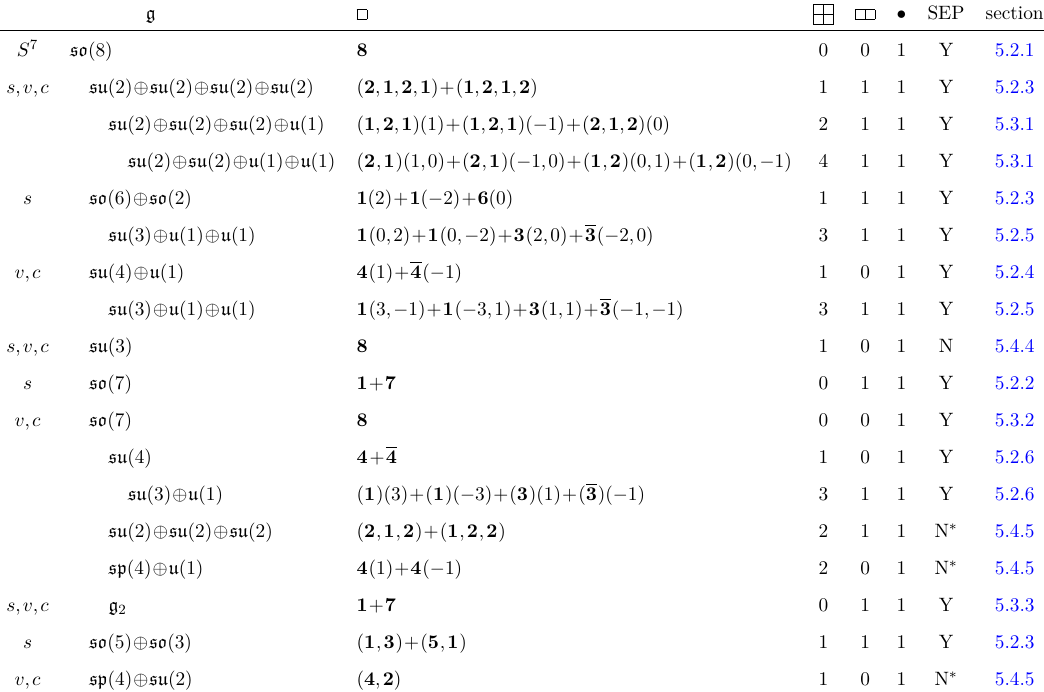
Table 2 . Examples of (non-)separating isometries on S 7